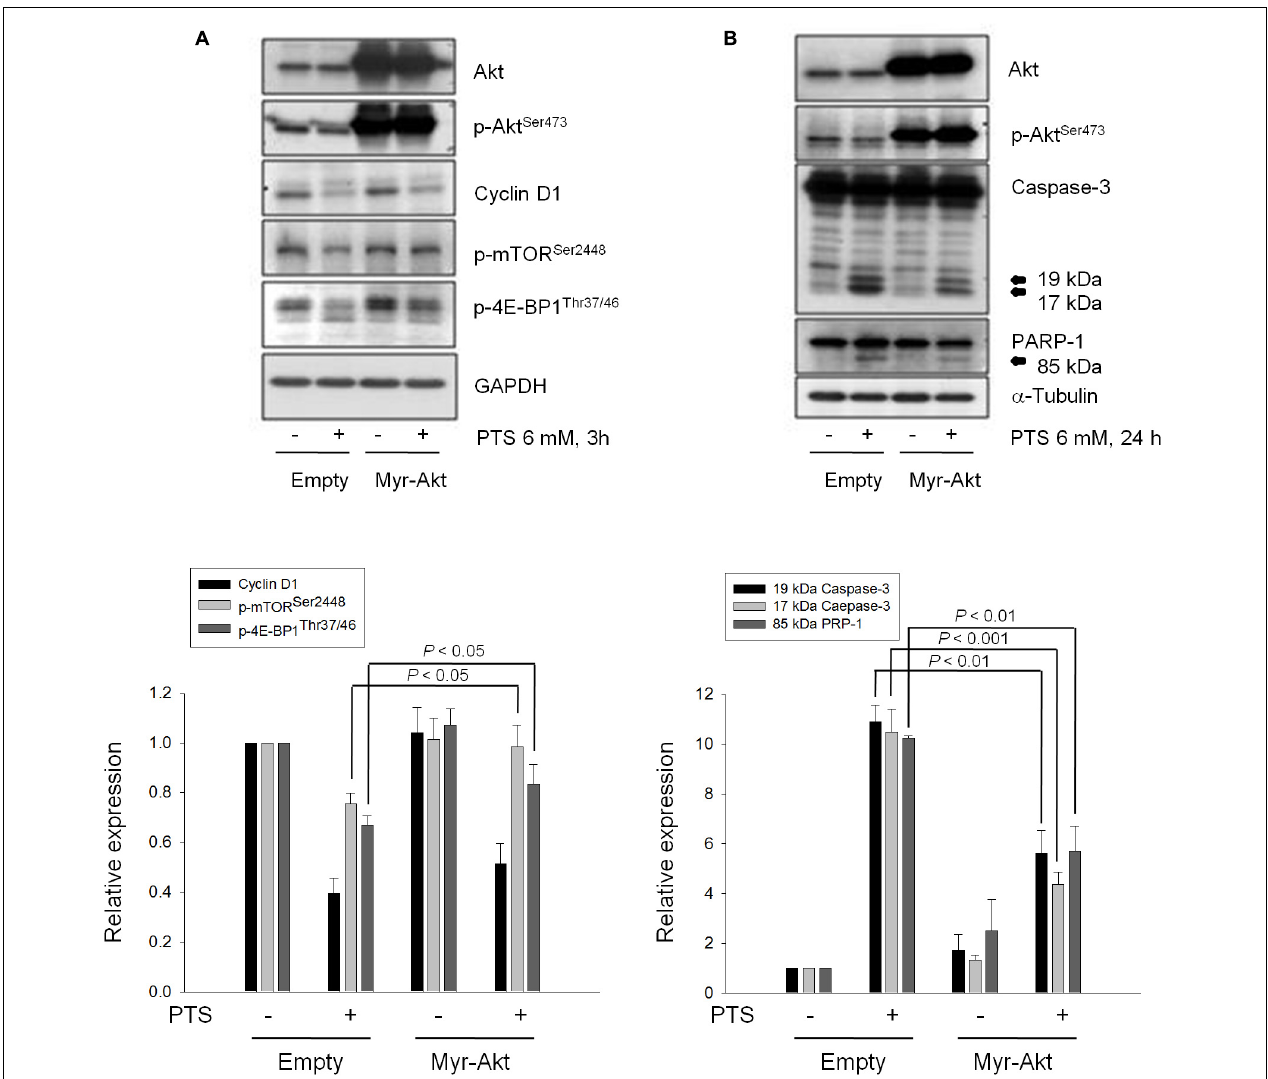
FIGURE 4 | Effect of Akt on PTS-induced alteration in several protein expressions. PC-3 cells were transfected with Myr-Akt plasmid. Then, the cells were incubated in the absence or presence of PTS for 3 (A) or 24 h (B) . The cells were harvested and lysed for the detection of the indicated protein by Western blot analysis. The expression was quantified using Image Lab Software 6.0 (BIO-RAD). The data are expressed as mean ± SD of three independent experiments.